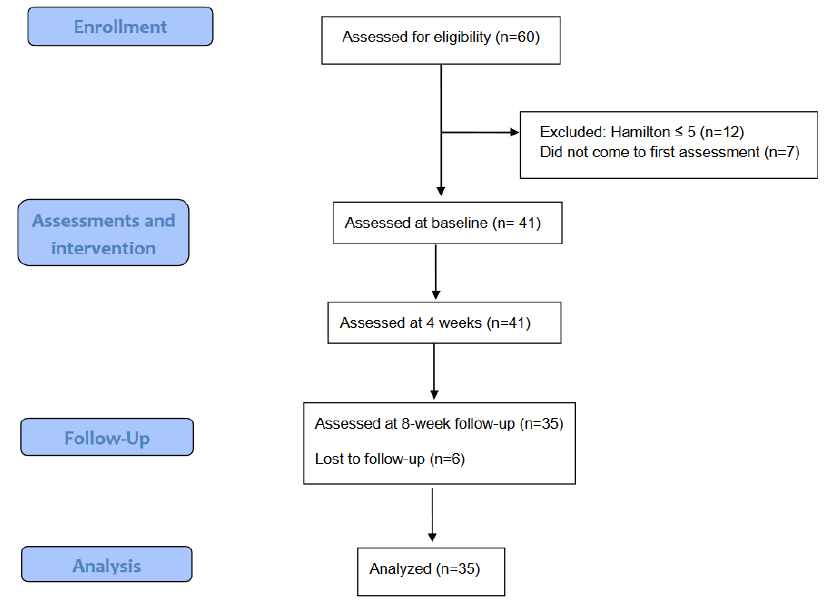
Figure 1. Flow chart of the sampling process.